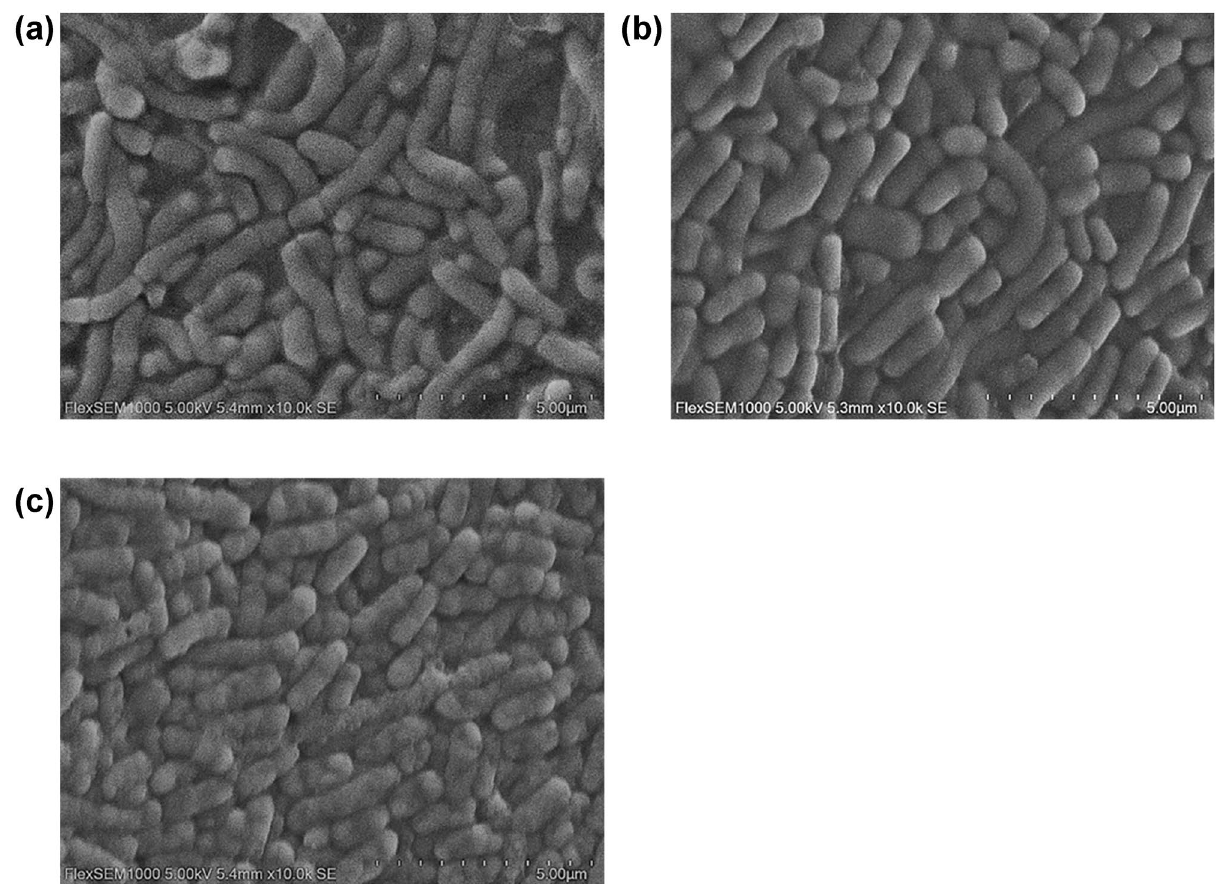
Figure 3. Scanning Electron Microscopy imaging of cells cultivated at ( a ) 30 °C, ( b ) 37 °C and ( c ) 44